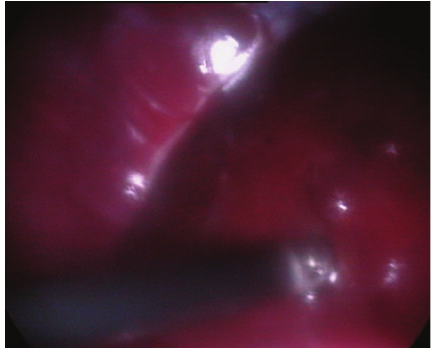
Figure 34: Two-dimensional ultrasonographic sagittal scan of right liver lobe in seven-year-old mixed-breed intact male dog showing noncystic cavitary lesions with generalized increase in parenchymal echogenicity.